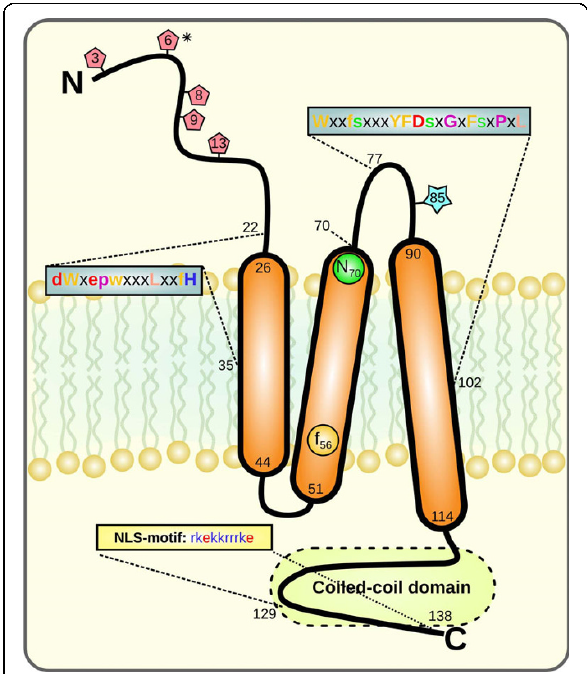
Figure 1 Schematic image of the human TMEM18 protein ’ s features . TMEM18 has three transmembrane a -helices and the N- terminal and second loop probably face the inside of the nucleus, whereas the first loop and the C-terminal are oriented towards the cytoplasm, according to predictions by Phobius. The N-terminal contains five predicted O- b -GlcNAc glycosylation sites (red pentagons) and the second loop contains one phosphorylation site (blue star). Also, one of the glycosylation sites (*) is potentially targeted by phosphorylation. The C-terminal is annotated to contain a Coiled-coiled domain and an NLS-motif. The protein is highly conserved: blue boxes represents well conserved motifs, capital letters represent amino acids that are completely conserved in all investigated organisms and lower cases represent those conserved in 90%. Circles represent single conserved residues. The circles and amino acid letters are colored according to Zappo color scheme in Jalview. All numbers represent amino acid positions, starting at the